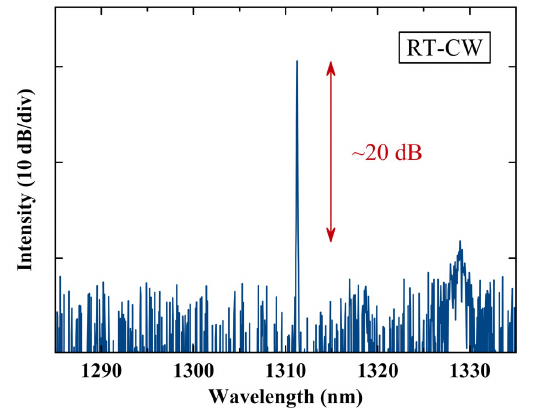
Figure 10. Lasing spectrum at pumping power of approximately 800 µ W. (reprinted with permission from reference [26], IEEE).